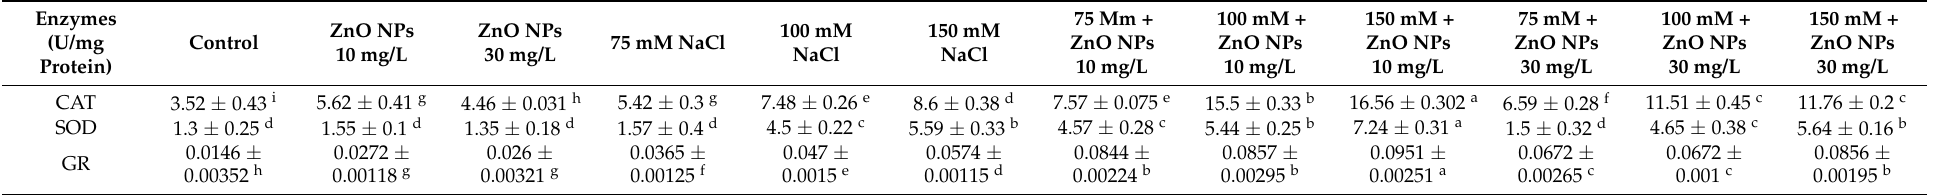
Table 1. Effect ZnO NPs (10 mg/L and 30 mg/L) on catalase (CAT), Superoxide dismutase (SOD), and Glutathione reductase (GR) antioxidant activities (U/mg protein) in the shoot of Salvia officinalis cultivated 0, 75, 100, and 150 mM of